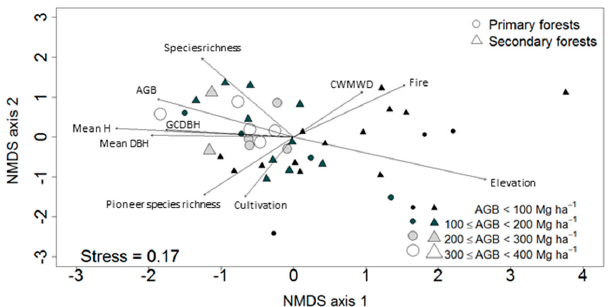
Figure 3. NMDS (non-metric multidimensional scaling) ordination for the study plots. Arrows indicate the environmental and forest characteristics which are significantly associated with NMDS axis scores (envfit function, p < 0.05). Abbreviations: CWMWD, community-weighted mean wood density; GCDBH, Gini coefficient (DBH basis); MeanH, mean tree height.